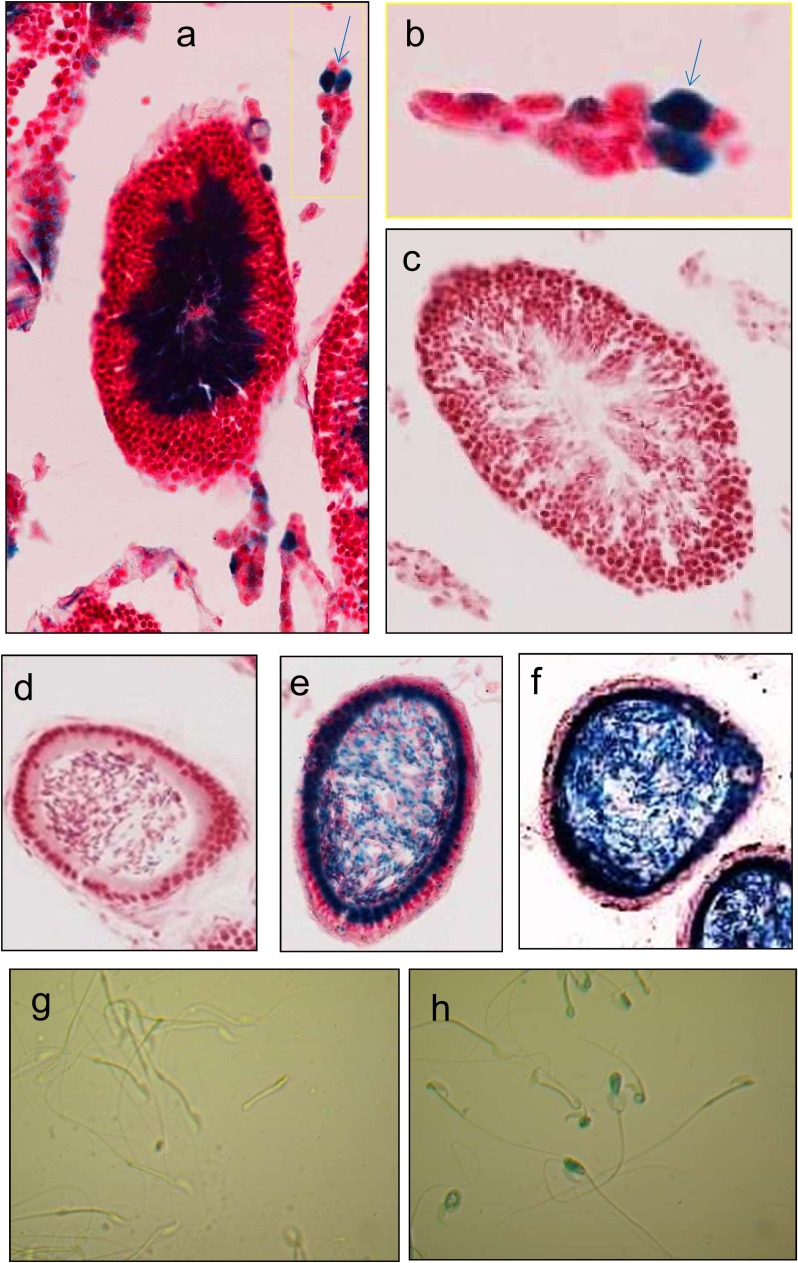
Histological X-Gal staining of the expression of Azin2 in the testes, epididymides and sperm cells of WT and Azin2 KO mice.a) Cross section of a seminiferous tubule from KO testis, showing positive X-gal staining (blue) in the inner part of the tubule where spermatids and spermatozoa are located (counterstained with neutral red). b) Magnification of interstitial cells; blue arrow indicates positive X-gal staining cells. c) Negative X-gal reaction in seminiferous tubule from WT testis. d) Cross section of epidydimis of WT mice. (e) Cross section of epidydimis of HET mice showing X-Gal stained (blue) and non-stained (red) spermatozoa. (f) Cross section of epidydimis of KO mice showing positive X-Gal staining of spermatozoa and epithelial cells. X-Gal staining of spermatozoa: negative in WT mice (g) and positive in KO mice (h).